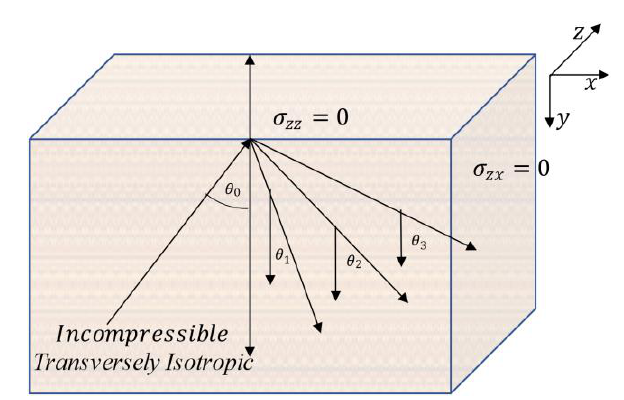
Figure 1. Geometry of the Problem.